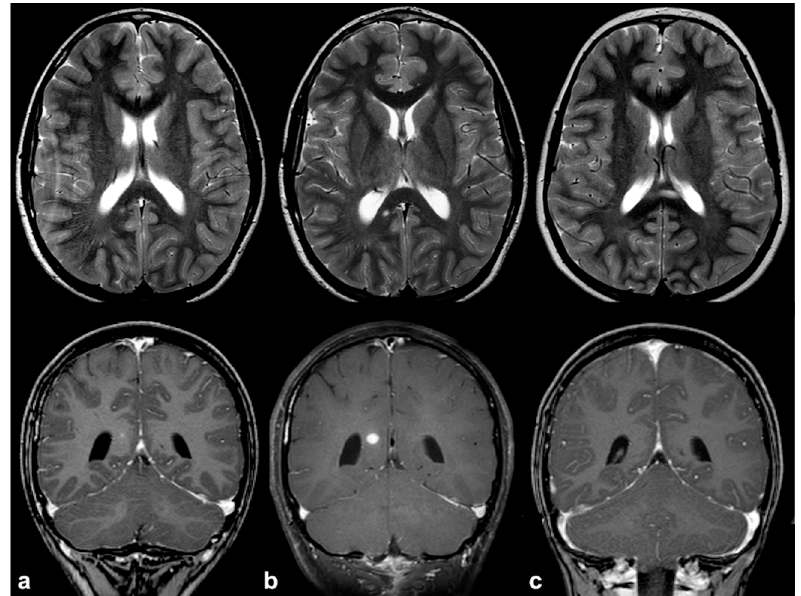
Figure 2. Longitudinal follow-up of atypical brain FASI in a 5 year-old NF1 male patient: axial TSE T2w (first row) and coronal post-contrast T1w (second row) MRI showing a oval-shaped lesion into the right occipital forceps of the splenium corpus callosum at three different time points ( a = 5, b = 5.5, and c = 6 years old). The lesion was T2-hyperintense with punctate enhancement at diagnosis, showed a transient volume increase with focal contrast enhancement, and then completely regressed at one-year longitudinal MRI follow-up.